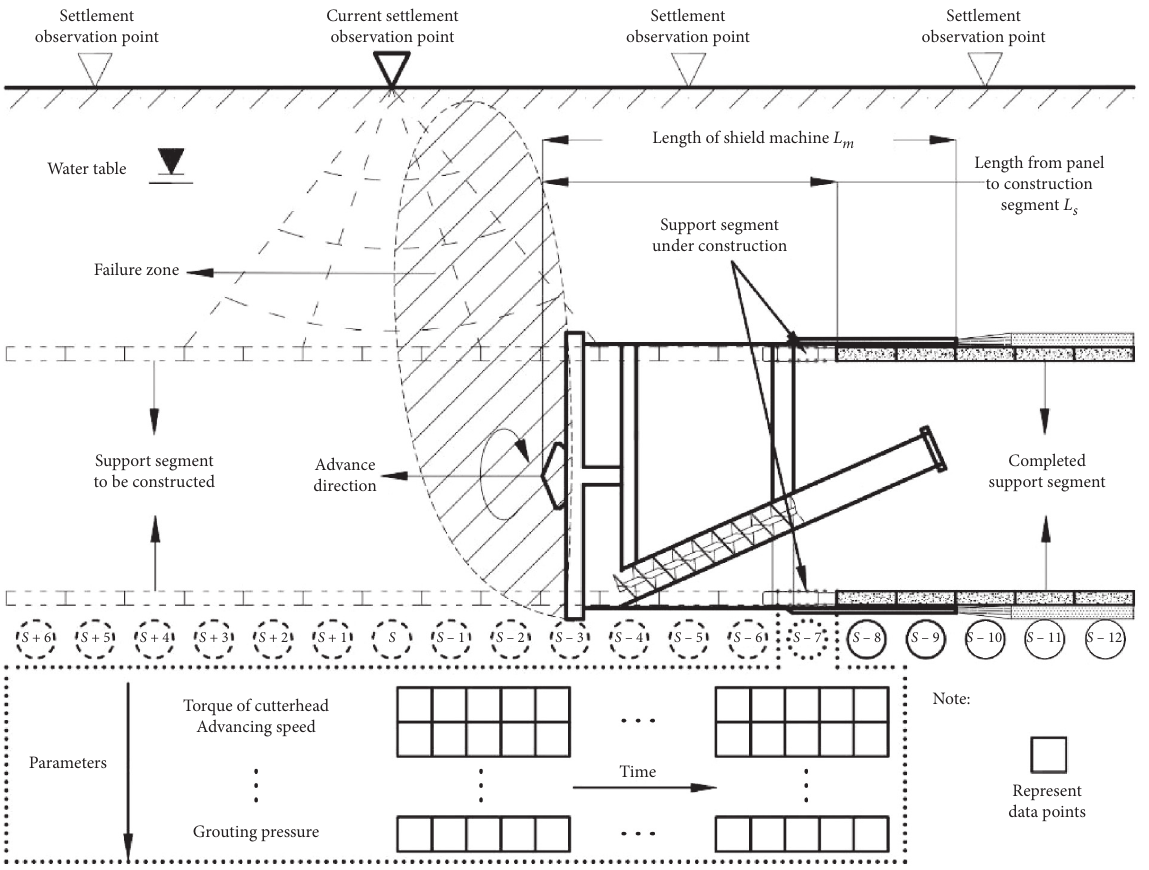
Figure 6: Schematic diagram showing the dynamic and continuous process of ground loss due to EPB shield tunneling.